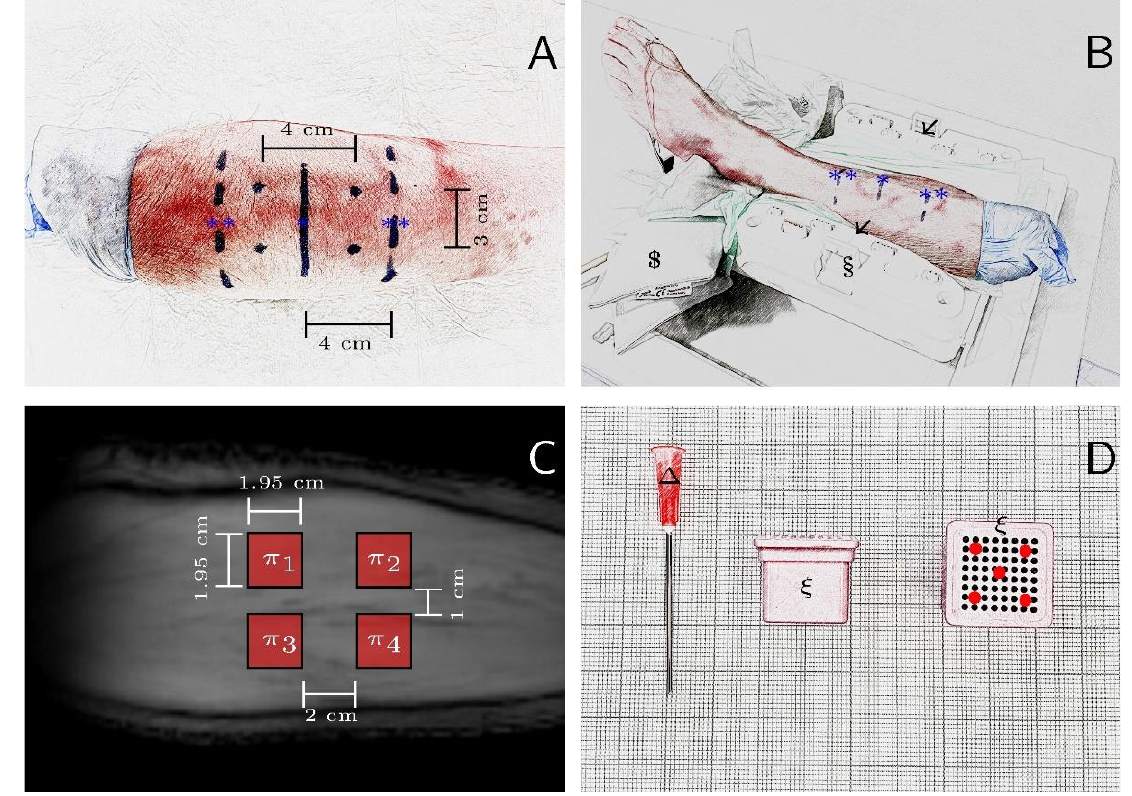
Figure 1. Experimental setup and sample preparation to investigate CEST metabolite sensitivity in situ using human cadaveric lower leg specimens. ( A ) For preparation, the specimens were marked to standardize lactate measurement sites. The en face view of the human calf where left is proximal, and right is distal. Marker lines indicate the widest part of the gastrocnemius muscle (*, solid line), and two parallel marker lines at a distance of 4 cm indicate accessory lines (**, dashed lines). ( B ) Specimens were placed supine and feet first in a clinical knee coil (§) (which is open for better illustration) and fixed using mechanical positioning aids such as sandbags ($). The marker lines were used to standardize specimen placement in the coil along the reference lines (black arrows). ( C ) Overlay of the four standardized regions of interest ( π 1–4 ) on the CEST reference image (300 ppm). ( D ) Grid needle blocks ( ξ ) viewed from the side and en face as well as the 18G needle ( ∆ ) on graph paper. To standardize intramuscular injections of lactate in terms of position (red dots) and depth (needle was fully inserted into the needle block), needle blocks were